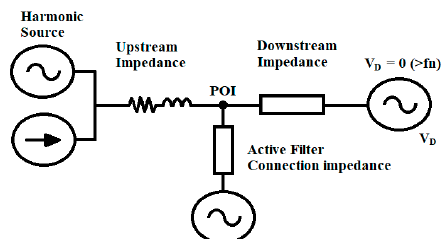
Figure 6. Simplified diagram for a harmonic active filter application considering harmonic voltage and current sources. Note: POI = point of inter-connection.